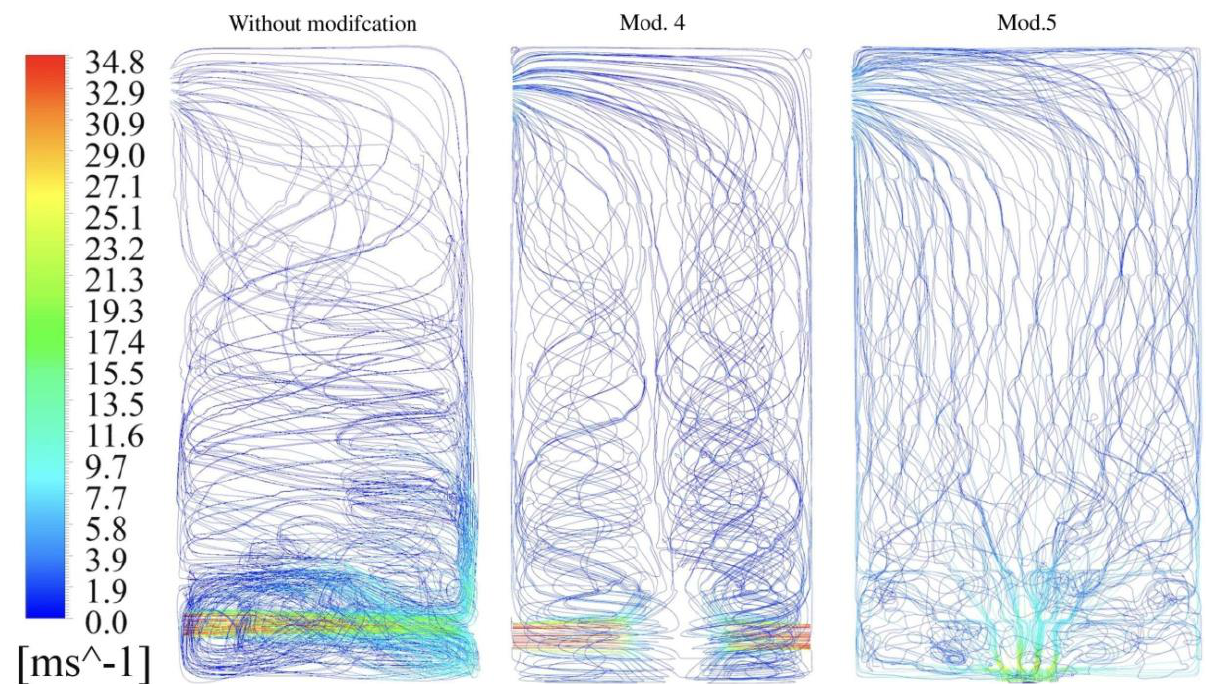
Figure 4. Visualization of the streamline-comparison of the chamber without modifications with the chamber with mod- ification 4 and 5.